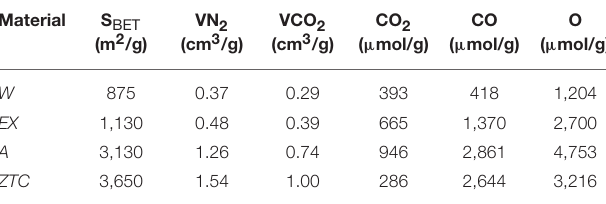
TABLE 1 | Textural and chemical properties of the studied microporous materials. Material S BET (m 2